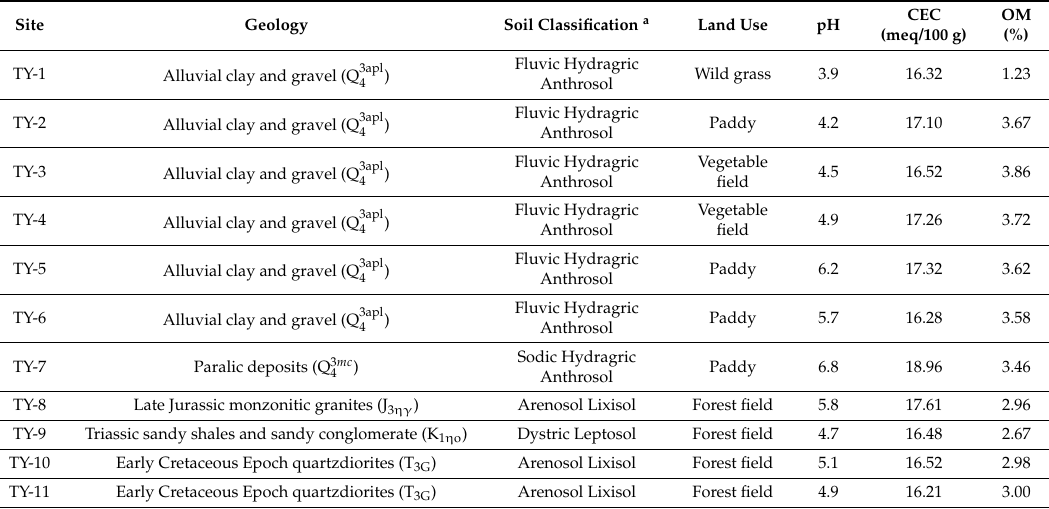
Figure 1. Location map of the study area and sampling sites. Table 1. The site geology and physicochemical properties of top soils in the studied area.